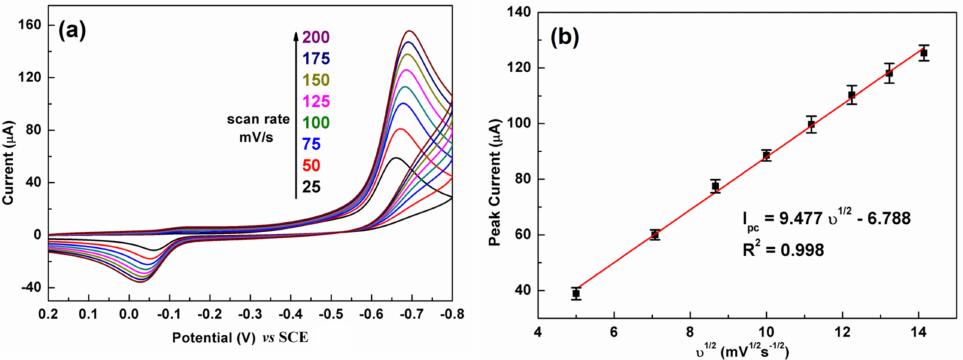
Figure 6. ( a ) The effect of scan rate on the CV response of the C-BN/GCE toward CAP (100 µ M) and ( b ) corresponding linear plot of reduction currents against square root of scan rate. (Conditions: 0.2 M PBS with pH of 7.0).